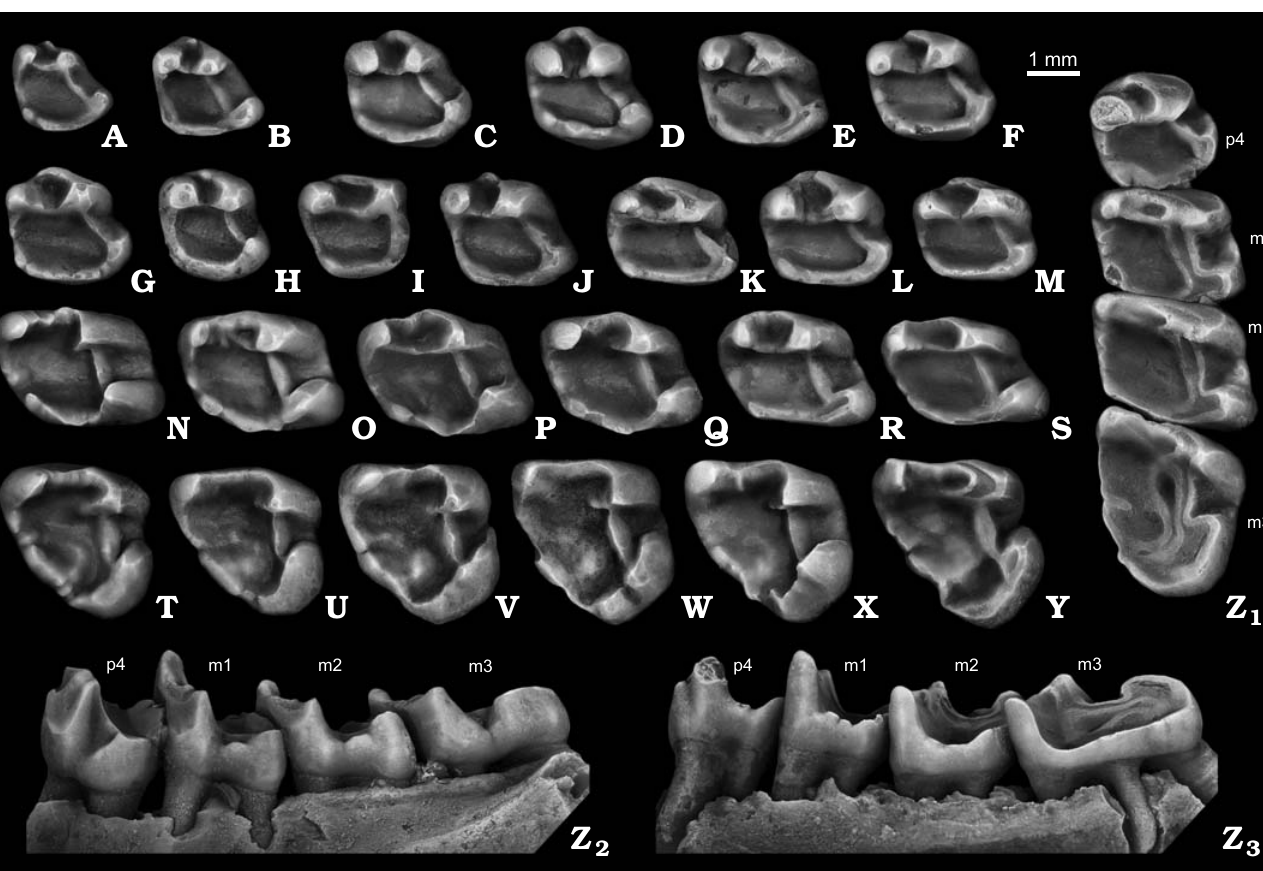
Fig. 4. Ground squirrel Spermophilus nogaici (Topachevsky, 1957) from the Early and Middle Pleistocene of southern Ukraine and southwestern Russia: Zhevakhova Gora 1 (A, C, N), Tarkhankut (D–F, O, T), Nogaisk (G–J, P, U–W, Z), Moiseevo 1 (Q), Cherevichnoe 1 (B, X), Tihonovka 1 (K, L), Bolshevik 2,I (M), lower cheek teeth (A, B, dp4; C–M, p4; N–S, m1–m2; T–Y, m3; Z, p4–m3), in occlusal (A–Z 1 ), labial (Z 2 ), and lingual (Z 3 ) views. A .